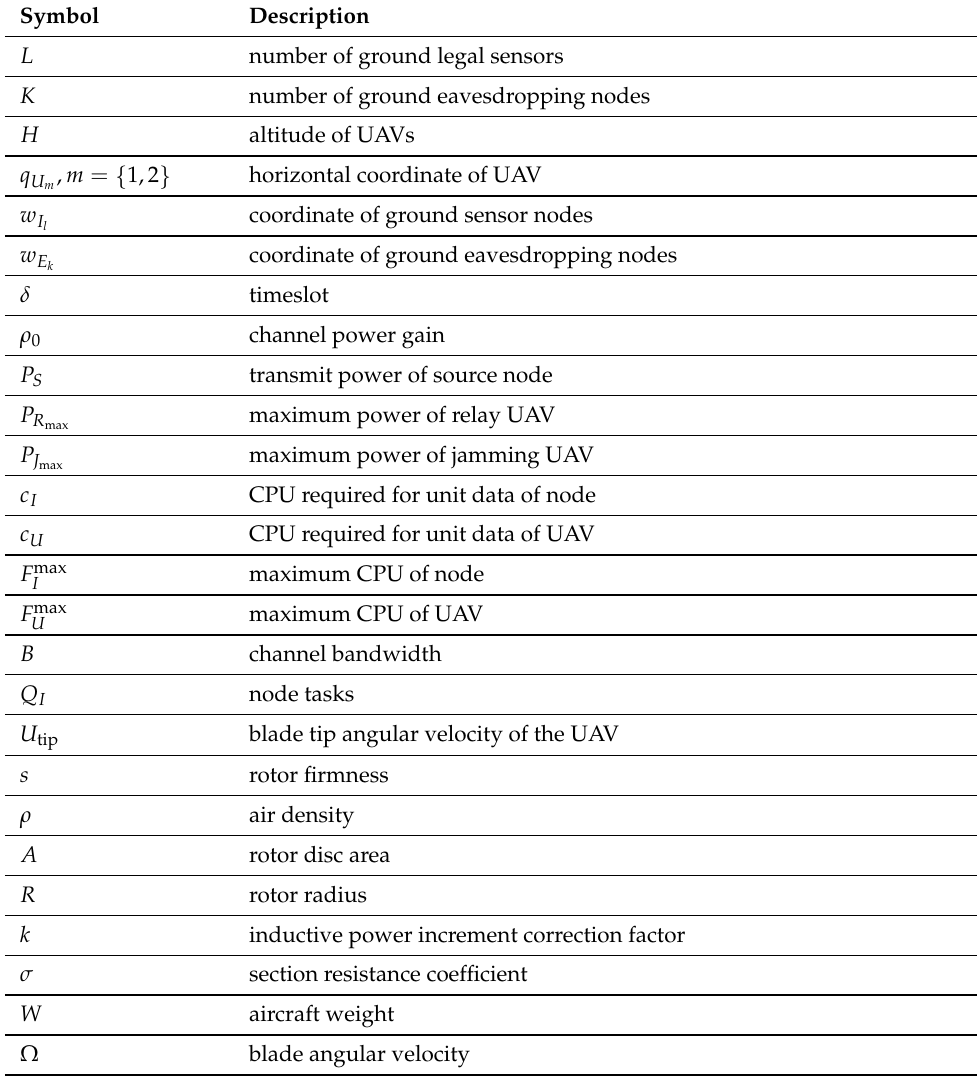
Table 1. Summary of